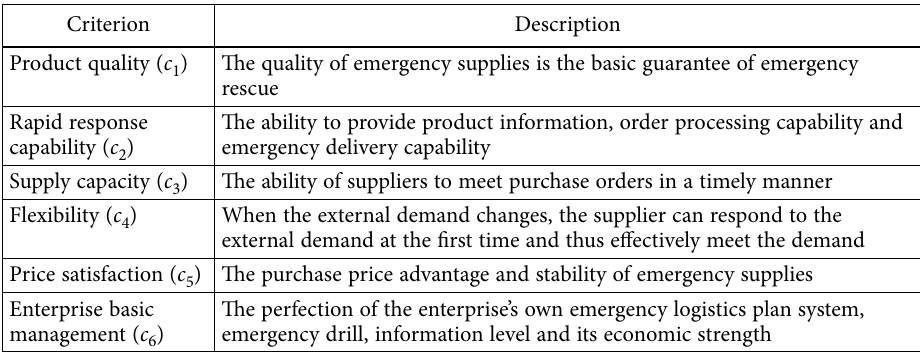
Table 3. Six criteria to select emergency logistics suppliers (Wang & Xu, 2016)